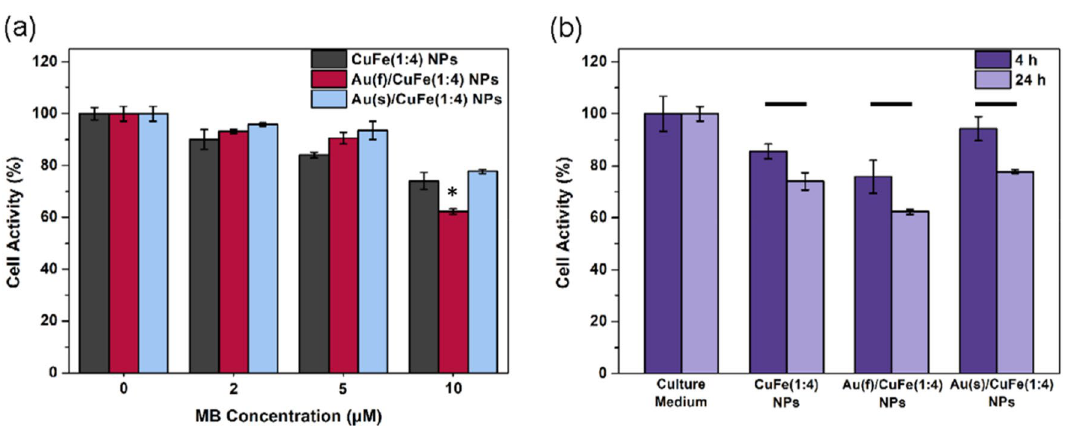
Figure 5. Dark toxicity of MB-NPs. ( a ) Cell activity after 24 h of incubation. ( b ) After 4 h and 24 h of incubation, cell activity with 10 μM MB of MB-NPs. (n =